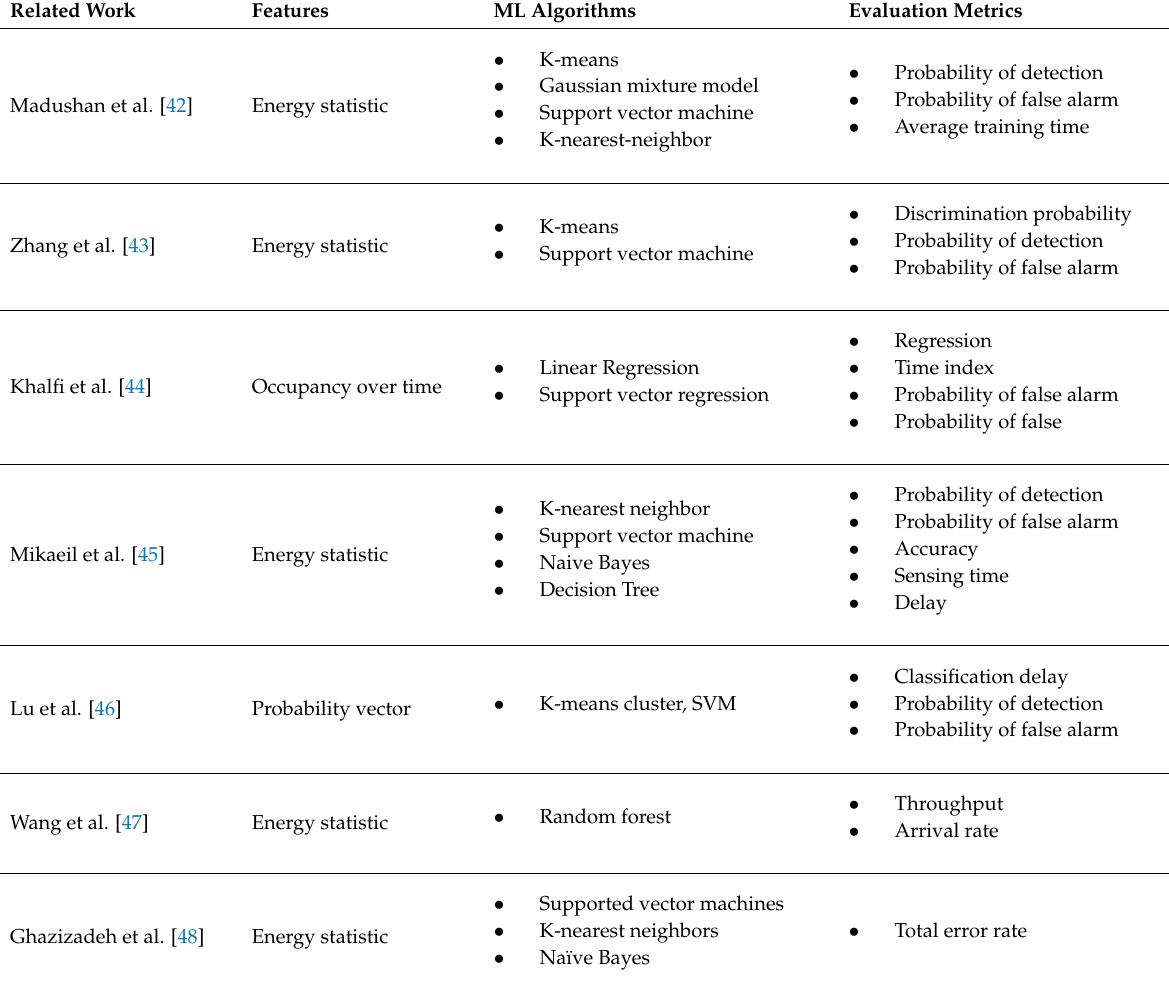
Table 2. Machine learning for spectrum sensing in cognitive radio